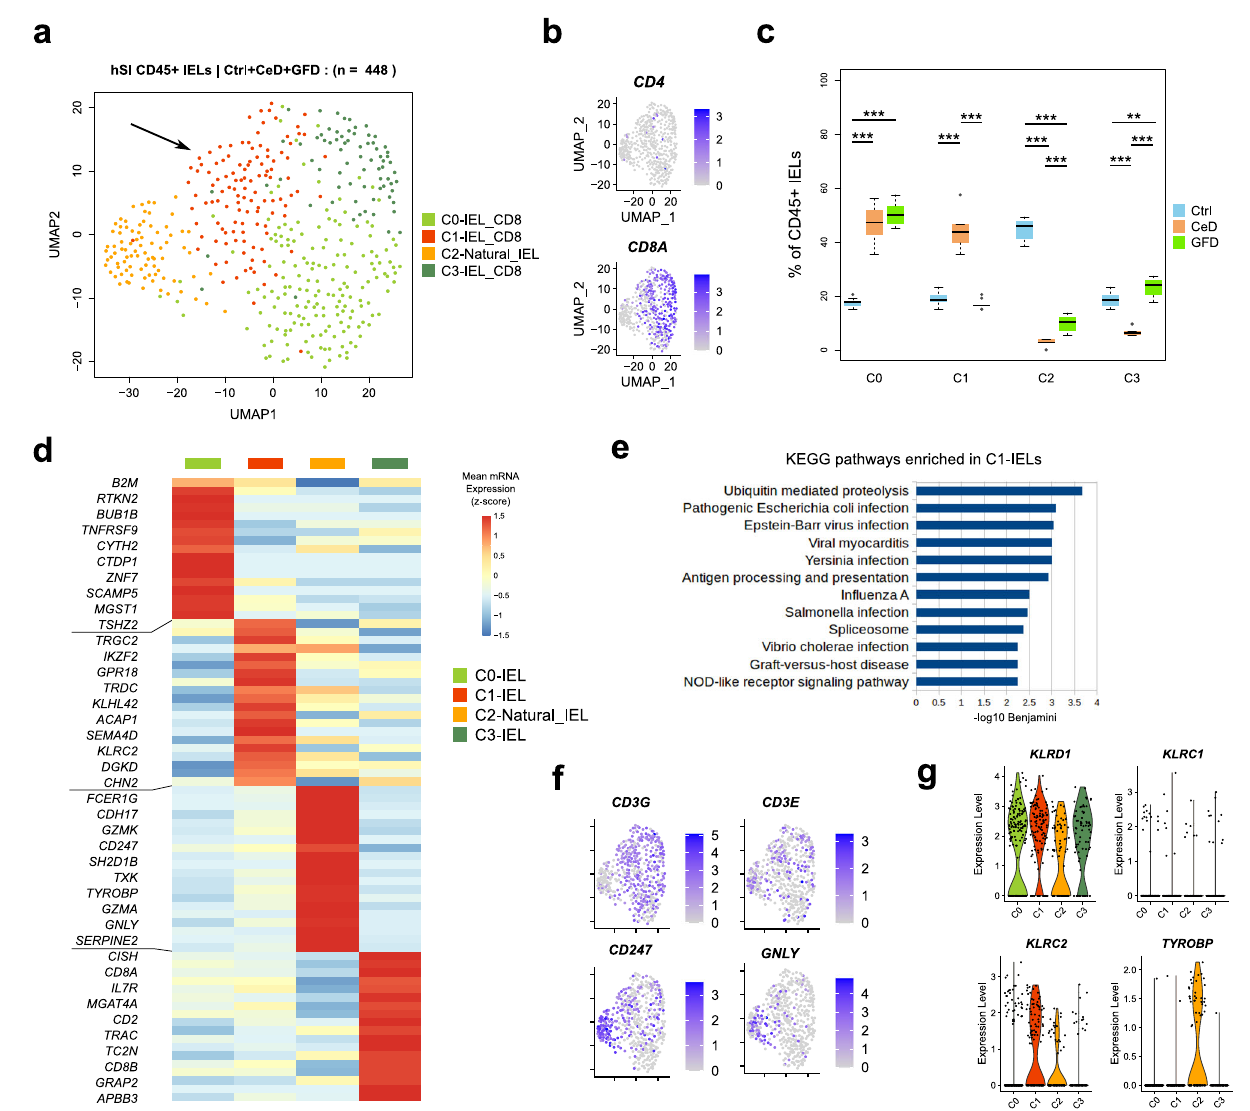
Fig. 6 | Single-cell landscape of CD45 + Intraepithelial lymphocytes of human small intestine in Ctrl, CeD and GFD samples. a UMAP clustering plot of hSI CD45 + Intraepithelial lymphocytes (IELs) derived from the epithelium of the Ctrl (controlsubjects),CeD(Celiacdiseasepatients)andGFD(Celiacpatientsongluten- free diet) samples. b Scatter plots depicting the CD4 and CD8A mRNA expression across the IELs from Ctrl, CeD and GFD samples on the UMAP plot. c Boxplots showing thedistributionof IELsacrossthe UMAPclusterspereachcondition(Ctrl, CeD and GFD) as compared to each other (center line, median; box limits, upper andlowerquartiles;whiskers,minimumandmaximumvalues;points,outliers,1.5x interquartile range; two-sided t-test p value<= 0.05 (C0: Ctrl vs CeD = 2.27 × 10 − 12 ,